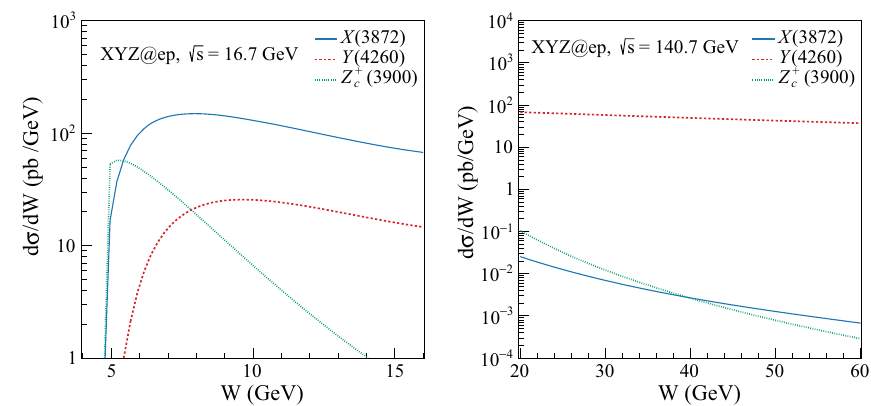
Fig. 4 Cross section as a function of W for XY Z in electron–proton scattering at EicC (left panel) and EIC-US (right panel). The region of Q 2 is 0.01 GeV 2 < Q 2 < 1.0 GeV 2 . The predictions in